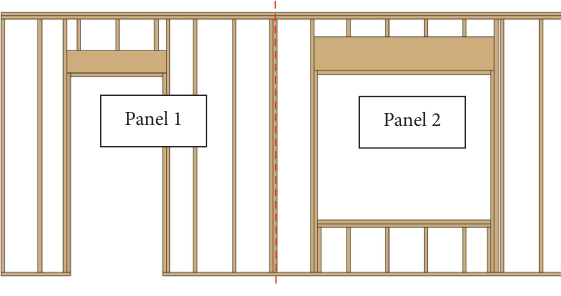
Figure 8: Panelized wall frames. Table 3: Panelization designs and their production duration.